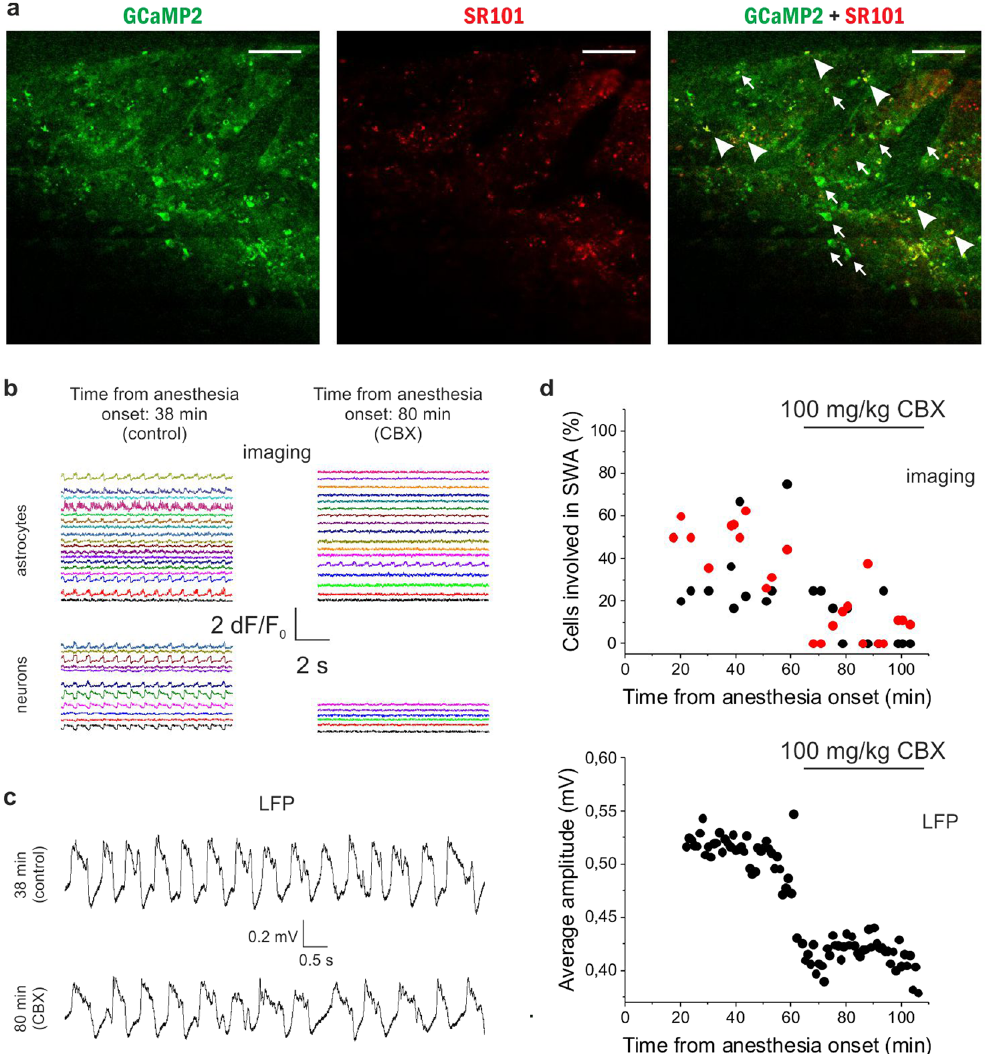
Figure 6. The gap junction blocker carbenoxolone (CBX) reduces the number of astrocytes and neurons taking part in the slow wave-associated network activity. ( A ) Expression of GCaMP2 (green), labeling of astrocytes with SR101 (red). Both neurons (some marked by arrows) and astrocytes (some marked by arrowheads) express GCaMP2. Scale bars: 100 µ m ( B ) Left: 10-sec segments of ∆ F/F 0 fluorescent intensity traces of all identified astrocytes (n = 18) and neurons (n = 11) in the imaged area in the absence of CBX at 38 min following anesthesia. Right: 10-sec segments of ∆ F/F 0 fluorescent intensity traces of all identified astrocytes (n = 17) and neurons (n = 6) in the imaged area in the presence of CBX at 80 min following anesthesia. Different cells were imaged at 38 and 80 min. ( C ) Representative LFP recordings low-pass filtered at 20 Hz at different stages shown in B. ( D ) Top : Ratio of V1 neurons (black) and astrocytes (red) in the field of view showing repetitive Ca 2 + transients under ketamine/xylazine anesthesia before and after i.p. administration of 100 mg/kg CBX. Individual markers represent data from each 60-sec imaging sessions. Bottom : Average amplitude of local field potential (LFP) positive deflections in each 1-minute segment of the LFP recording in the rat primary visual cortex V1 before and after i.p. administration of 100 mg/kg CBX. All data were recorded from the V1 area of a P44 rat (n = 24 imaging session, 60 s